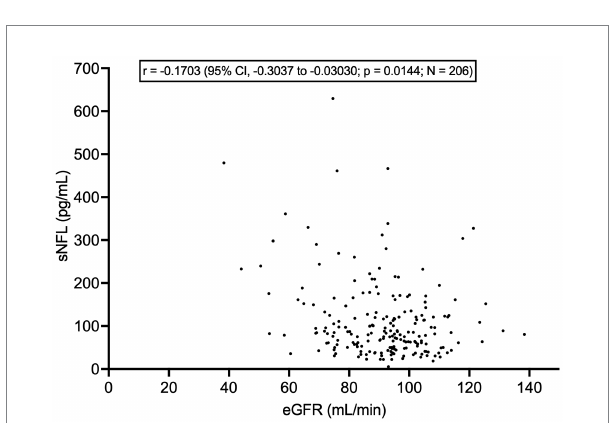
FIGURE 7 Correlation between serum NFL levels and estimated glomerular filtration rate. CI, confidence interval; eGFR, estimated glomerular filtration rate; NFL, neurofilament light chain; sNFL, serum neurofilament light chain.